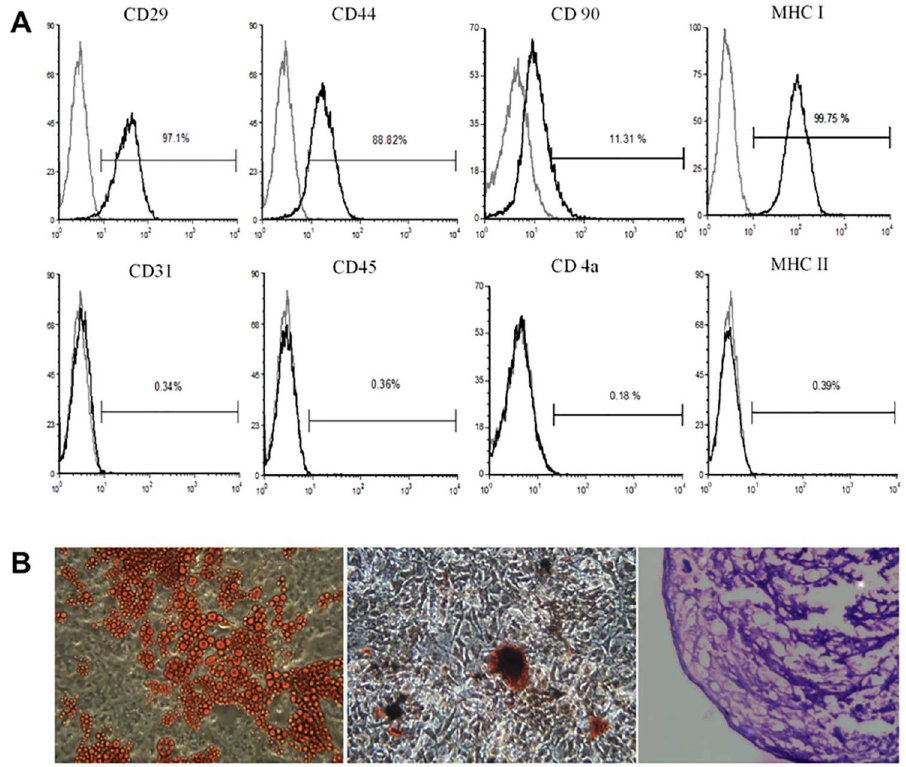
Fig 1. Isolation of multipotent Adipose-Derived Stem Cells (ADSCs) from pig subcutaneous fat depot. (A). Flow cytometric analysisof porcine (p) ADSCs. 1 x 10 6 cells were analyzedfor stem cells markers. Numbersindicate the percentage of stainedcells in the population (black) comparedwith the unstained control (gray). The x-axes represent the relativefluorescence intensity. (B). Multipotency of pADSCs. pADSCs were differentiated into adipocytes(left panel), osteocytes (middle panel)and chondrocytes (right panel)and stainedas describedin the text. Images were taken at 100 x magnification using phasecontrast